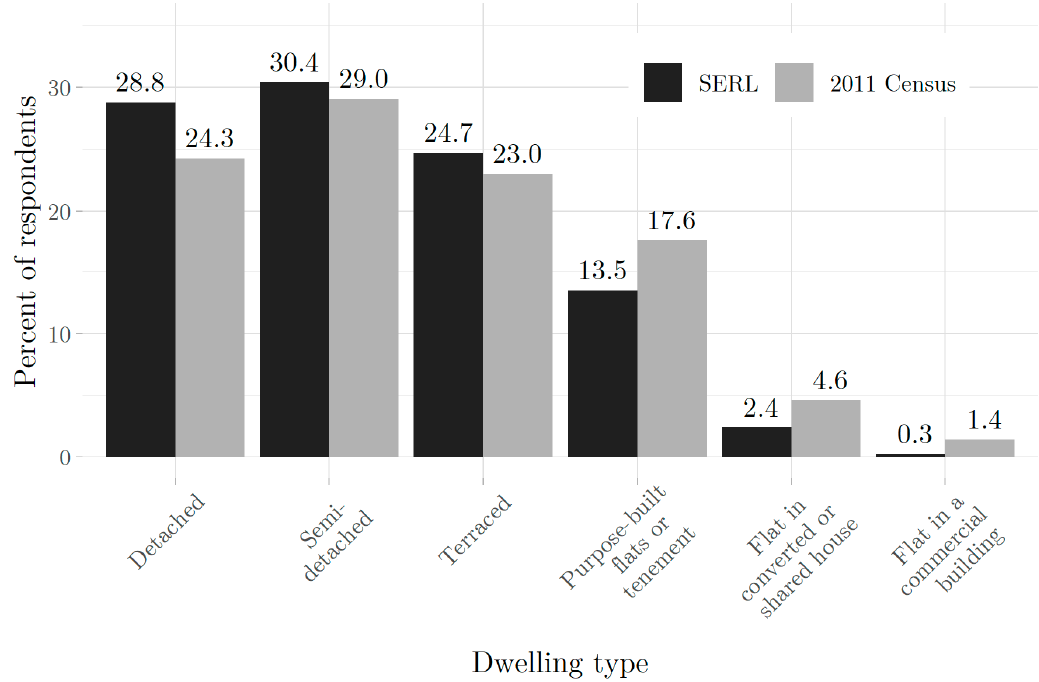
Figure 14. Dwelling types for SERL survey respondents (question B1) compared to the 2011 Census.